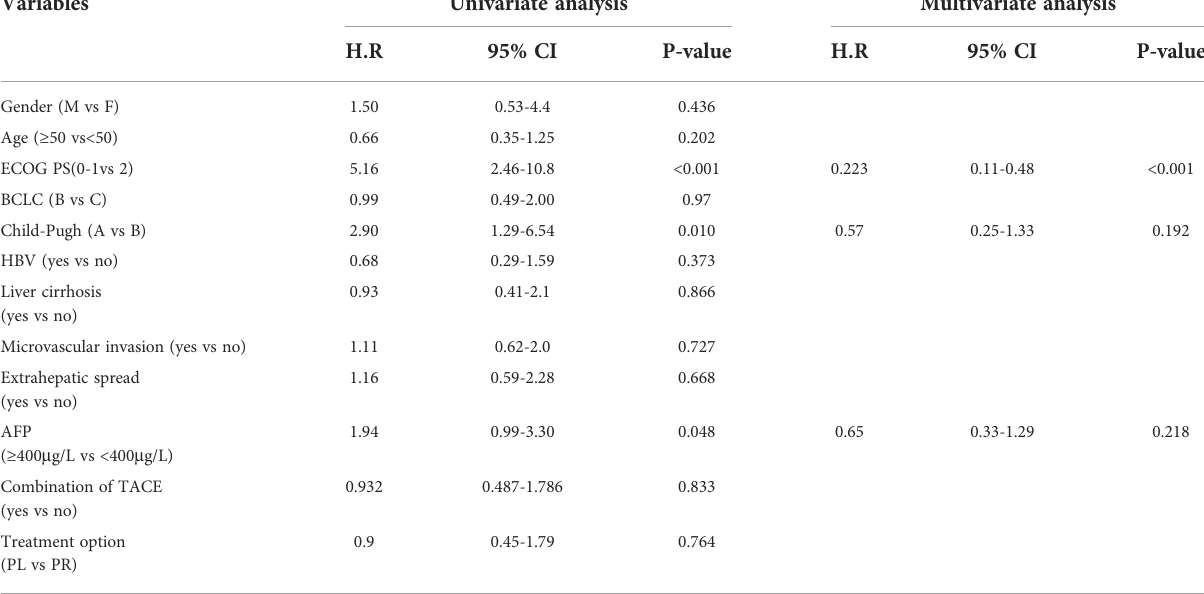
TABLE 5 Univariate and multivariate analysis of risk factors for overall